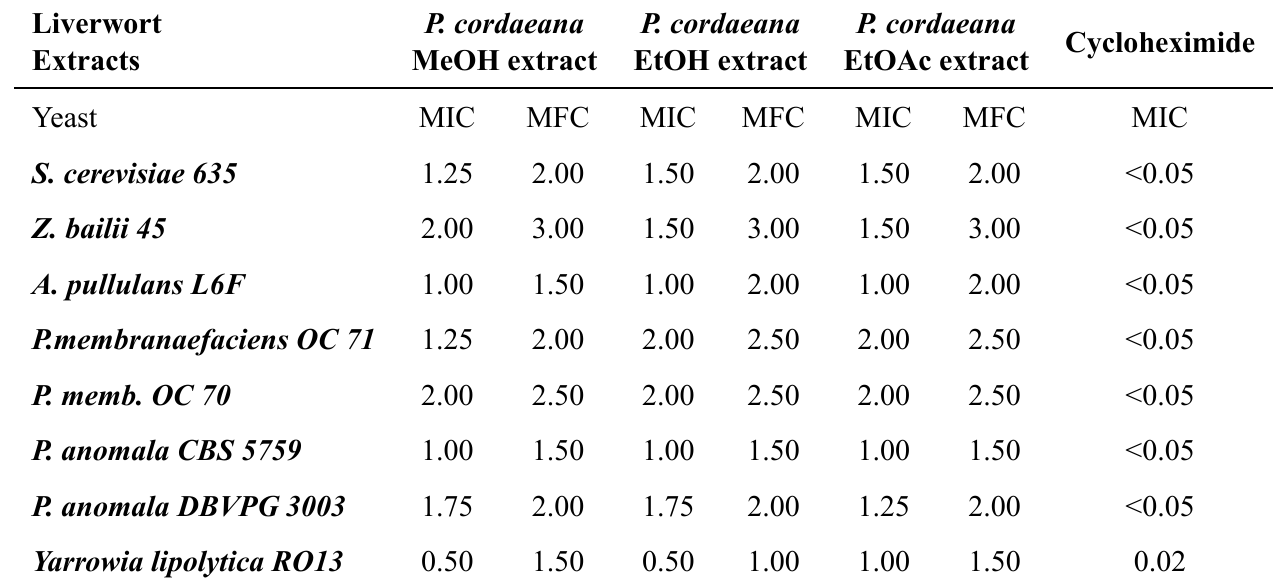
Table 2. Antimicrobial activity of P. cordaeana methanol, ethanol and ethyl acetate extracts (mg/mL). Liverwort